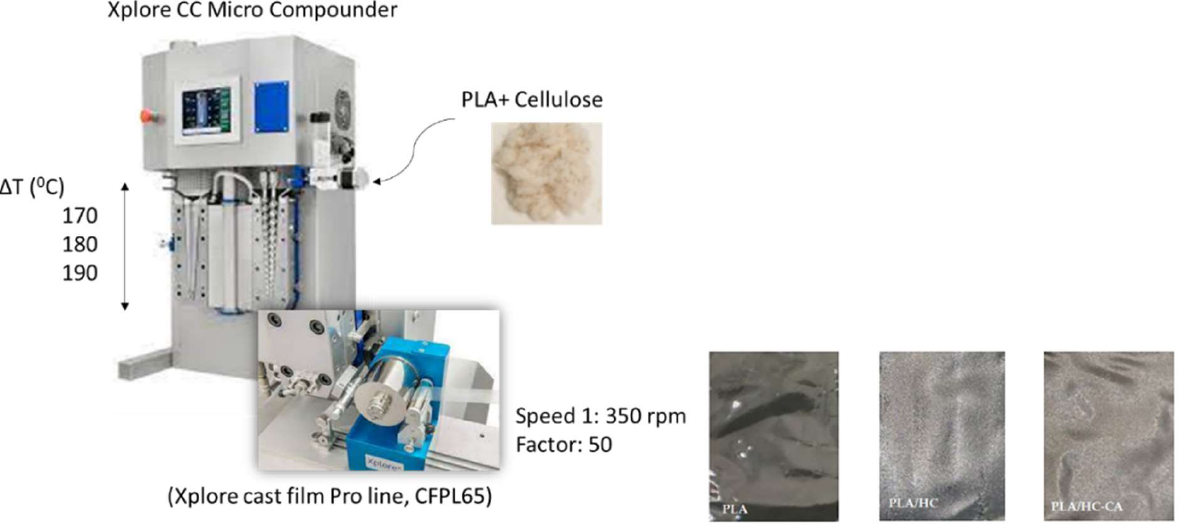
Figure 3. Scheme of the PLA-based biocomposite films manufacturing process performed in this work.